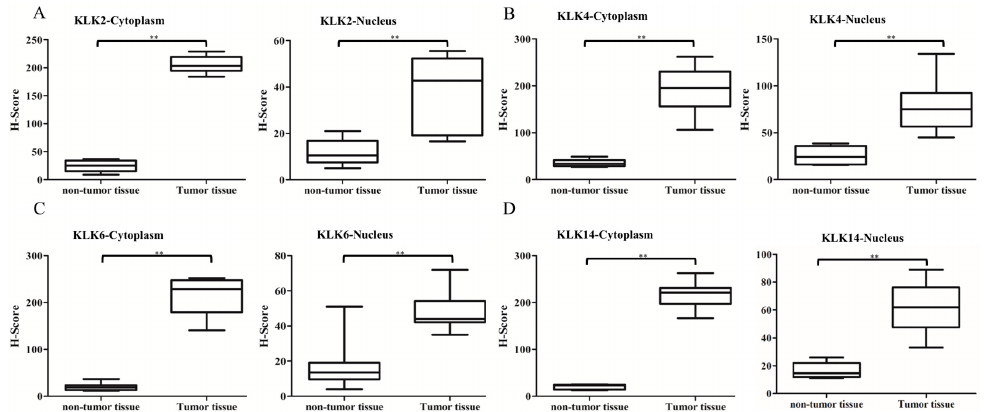
Figure 5. Significant KLK protein expression exhibited in PCa tissues either in the cytoplasm or nucleus. Box diagram of protein expression in surrounding normal tissues and tumor tissues. ( A ) KLK2; ( B ) KLK4; ( C ) KLK6; ( D ) KLK14. The data in the figure are the mean ± standard deviation. ** represents p < 0.001. 3.4. Flow Cytometric Evaluation of the Apoptosis and Necrosis of PCa Cells after Treated with EPA